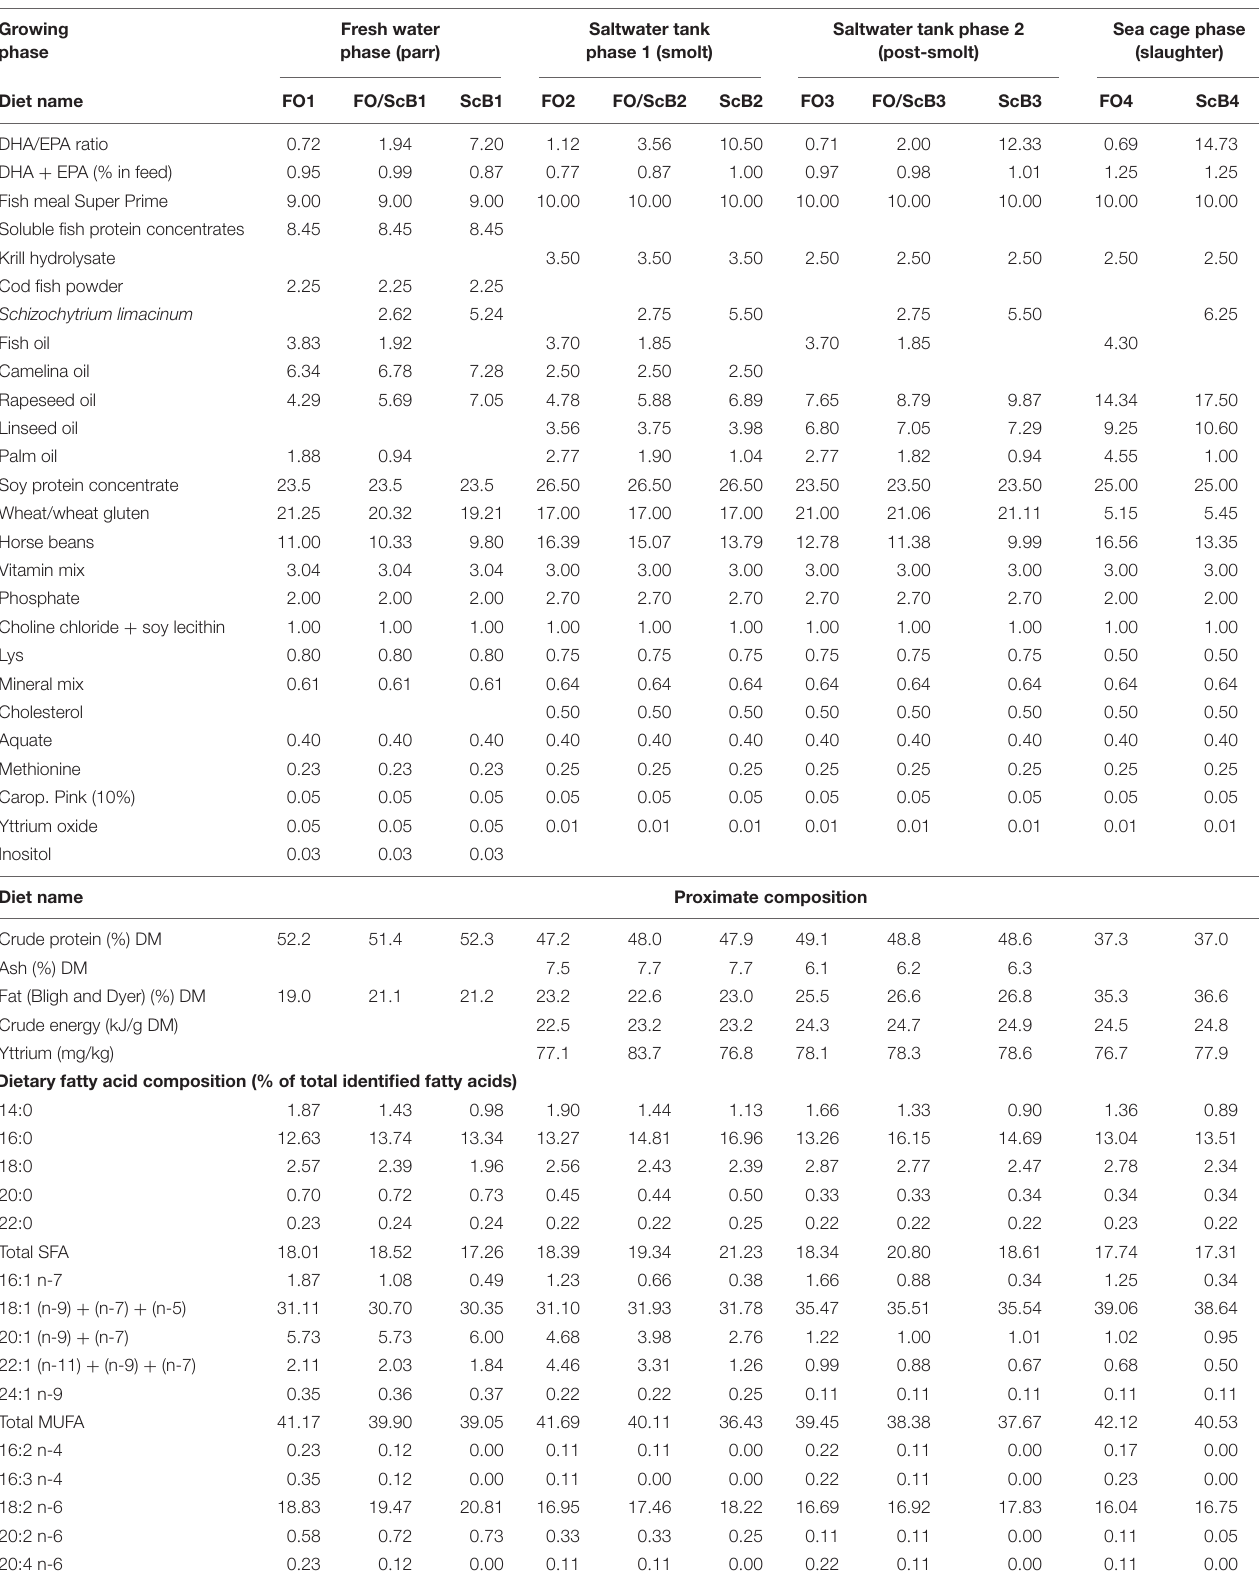
TABLE 1 | Experimental diets’ formulations (raw material inclusion levels in %) and chemical composition. Growing Fresh